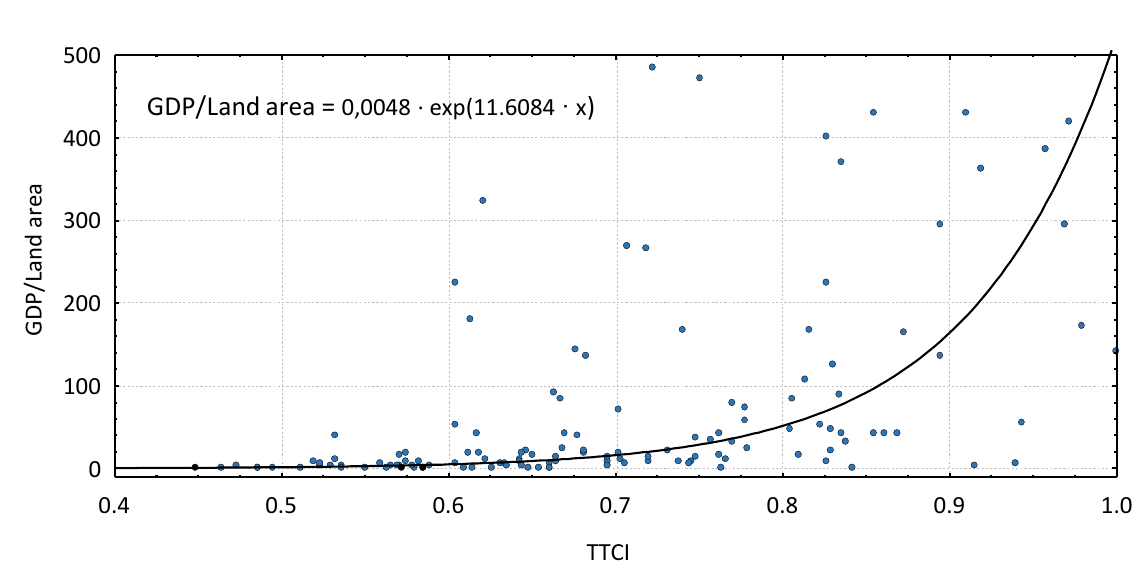
Figure 2. The efficiency of the land area use for tourism compared with the general TTCI